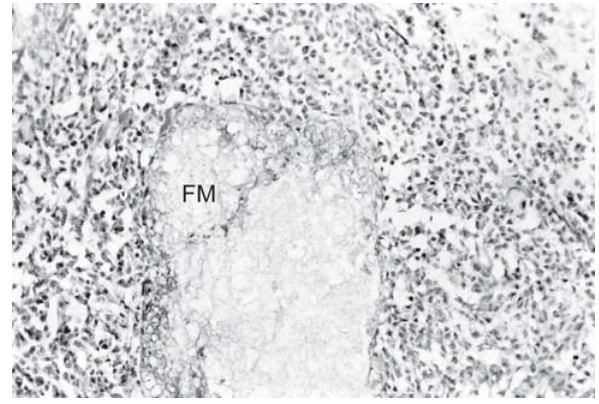
FIGURE 2 - Maisto paste. The filling material (FM) is surrounded by giant cells and some chronic inflammatory cells. H.E. X. 200